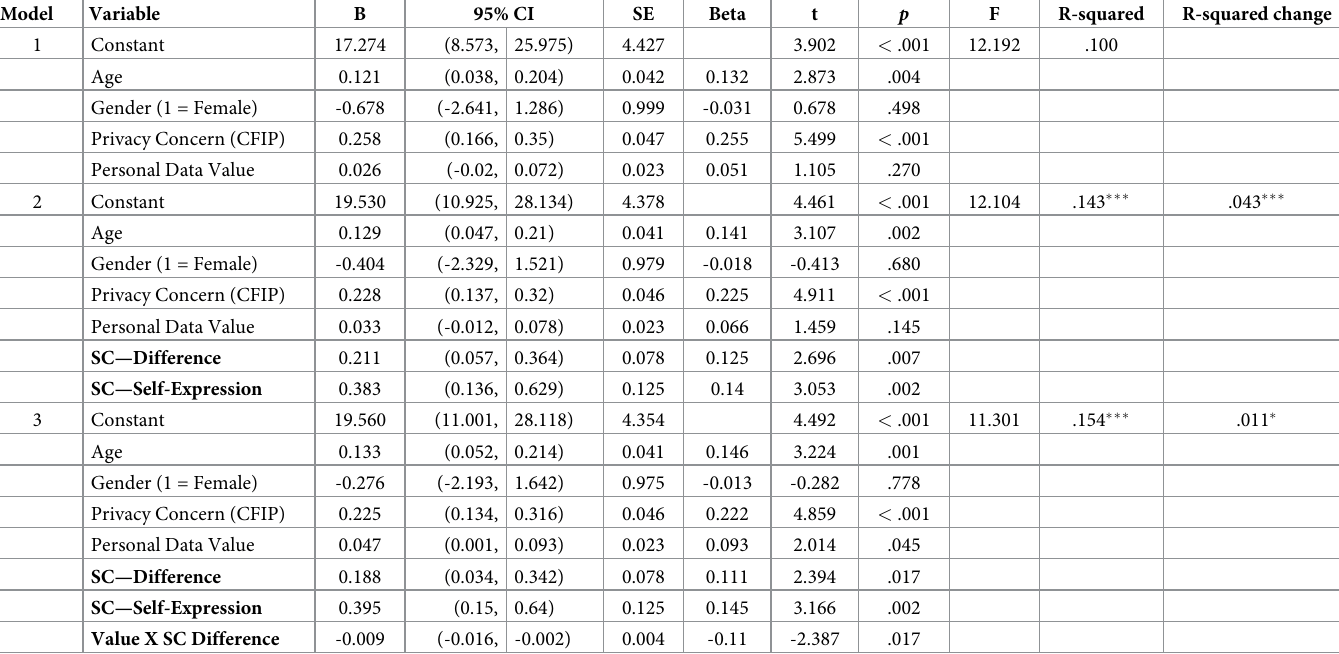
Table 6. Regression analysis predicting privacy behaviour from demographic variables, privacy concern, personal data value, self-construal difference, and self-con- strual self-expression.